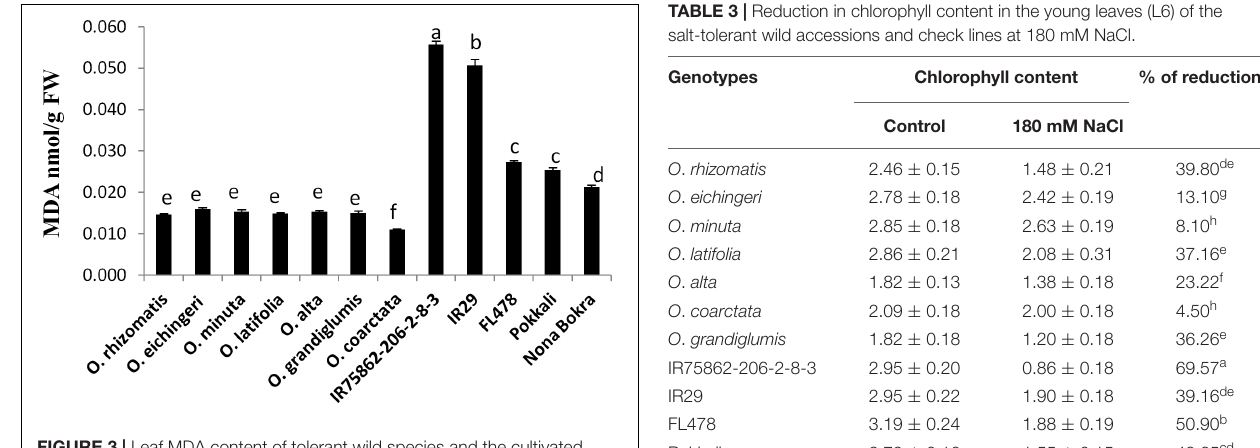
FIGURE 3 | Leaf MDA content of tolerant wild species and the cultivated checks. Leaf tissues were collected after 10 days from a 180 mM NaCl-treated experimental set up and mean value of MDA ( n = 3) was calculated in nmol per gram FW of the leaf. Vertical bar indicates ± standard error. Different letters in error bars are statistically different as inferred from DMRT at p <